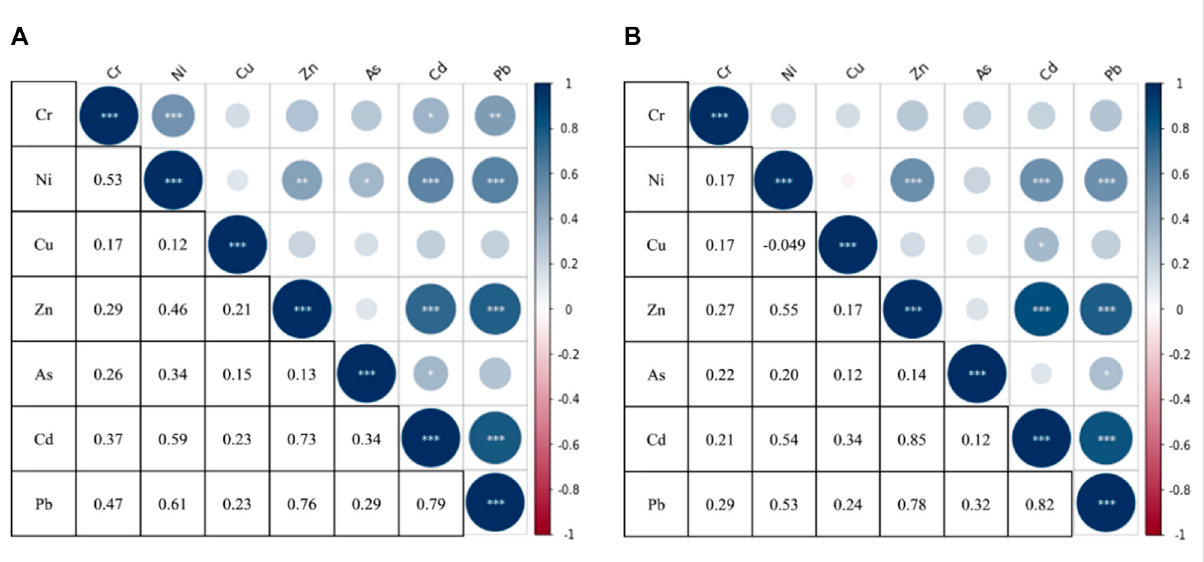
FIGURE 5 Pearsoncorrelationmatrixbetweentotalheavymetals. (A) Suface; (B) Mesocosms;* p ≤ 0.05,** p ≤ 0.01,andthesizeofthecirclerepresentsthe absolute value of the correlation coef fi